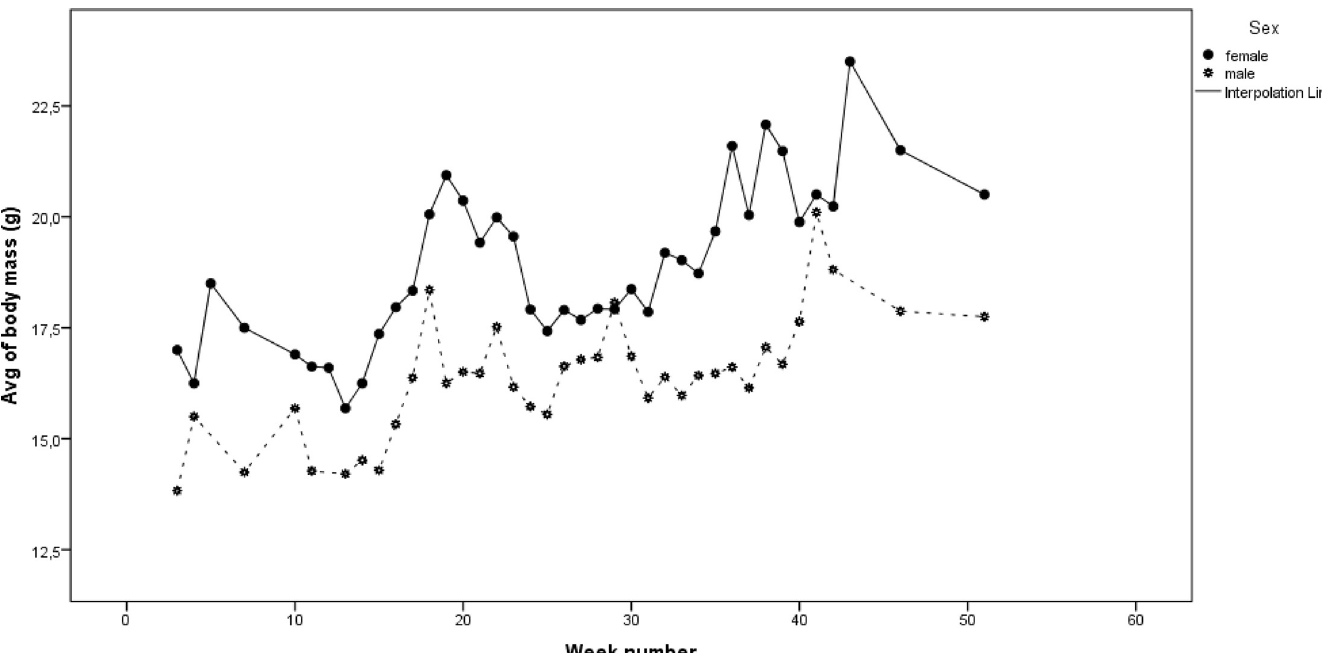
Fig 1. Fluctuations in the body mass of the adult population during the year (data collected in period 2002–2015).